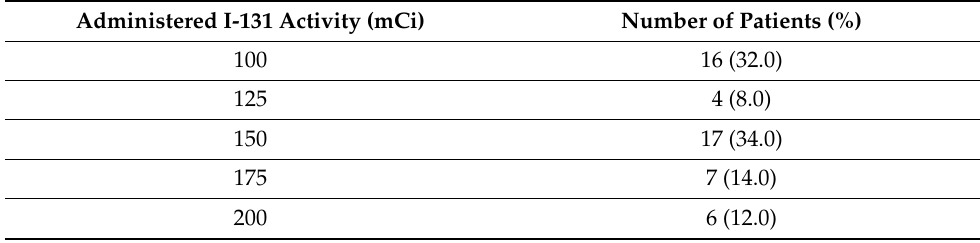
Table 2. The administered I-131 dose received by